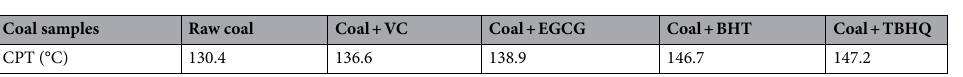
Coal samples Raw